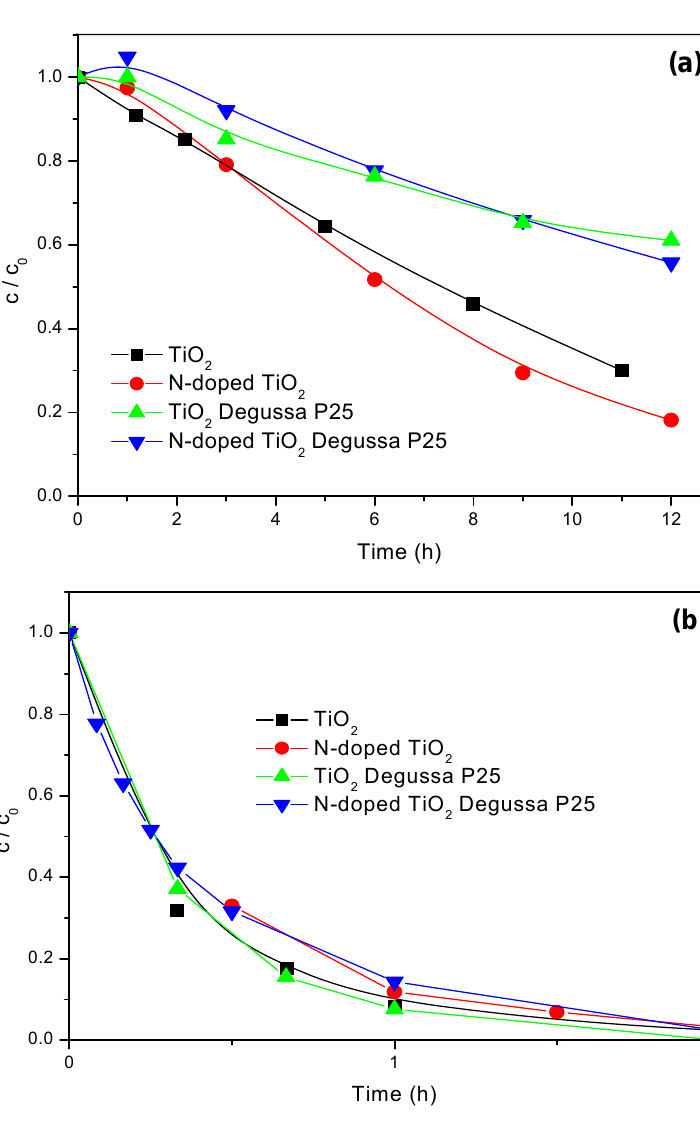
Figure 5. Disappearance of mecoprop (2.7 mmol/dm 3 ) under visible (a) and UV (b) light irradiation (1.0 mg/cm 3 of